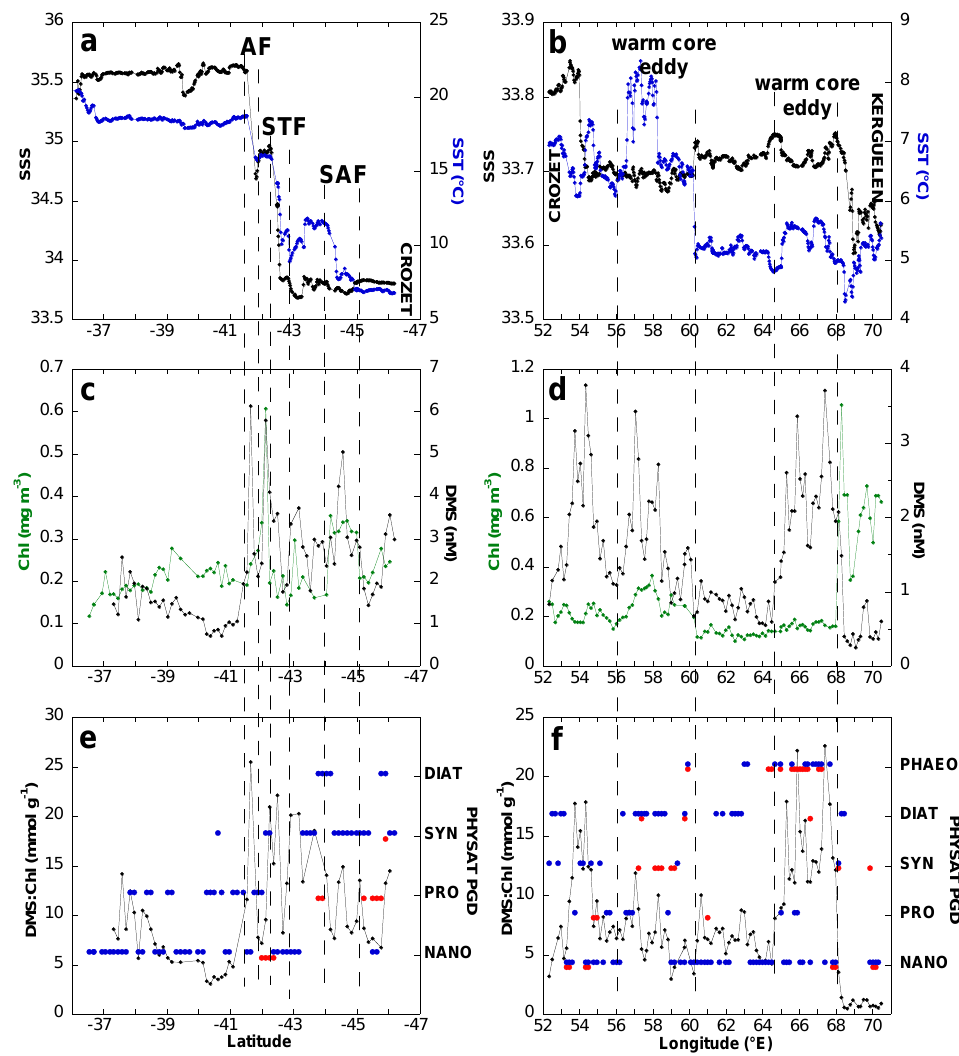
Fig. 5. Spatial variations of (a, b) sea surface temperature (SST: ◦ C, in blue) and salinity (SSS, in black), (c, d) ocean color (Chl: mgm − 3 , in green) and sea surface dimethylsulfide concentration (DMS: nM, in black), (e, f) DMS-to-Chl ratio (DMS:Chl, mmolg − 1 , in black) and monthly (red dots) and monthly climatological (blue dots) composites of phytoplankton group dominance along two DMS transects carried out in February 2005 in the Indian Sector of the Southern Ocean (right panels: longitudinal transect between Kerguelen and Crozet, left panels: latitudinal transect between Crozet and La R´eunion). AF: Agulhas front, STF: subtropical front, SAF: subantarctic